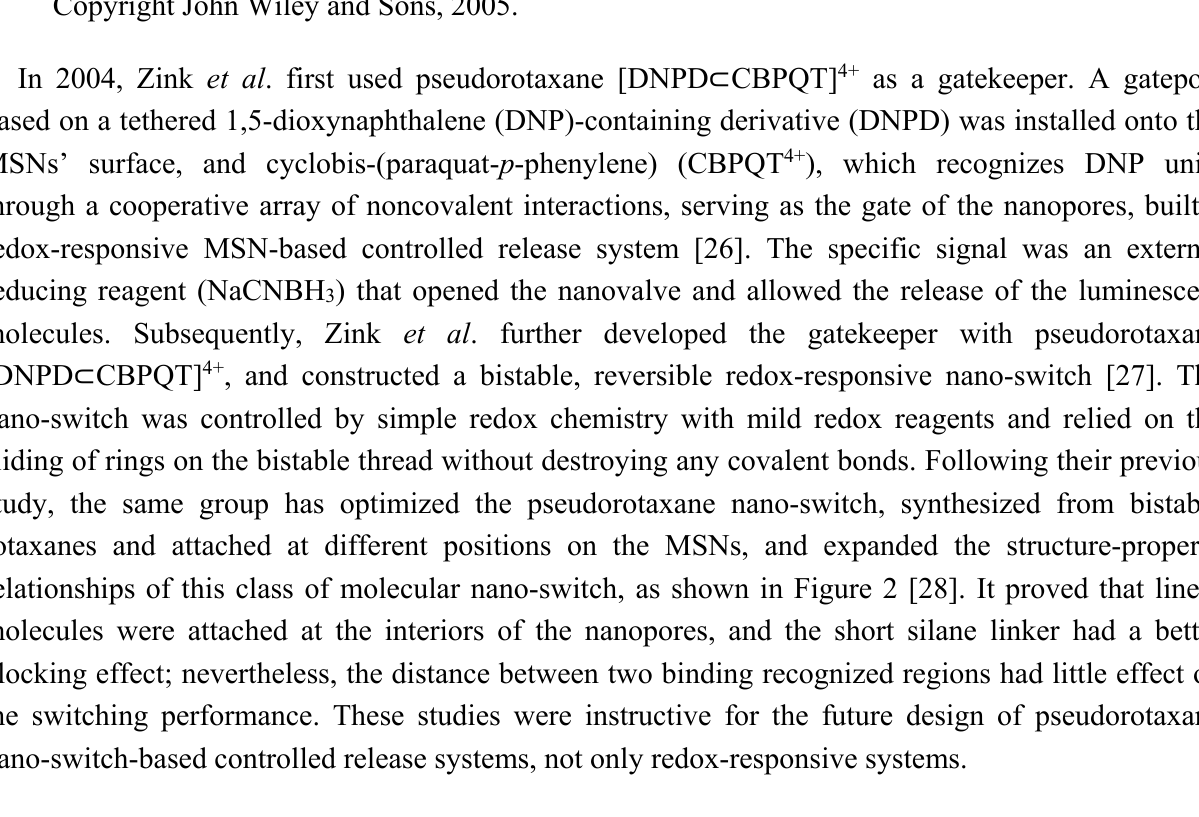
Figure 1. Schematic of the stimuli-responsive controlled release system (magnet-MSN) based on MSNs capped with Fe 3 O 4 nanoparticles. Reproduced with permission from [23]. Copyright John Wiley and Sons,